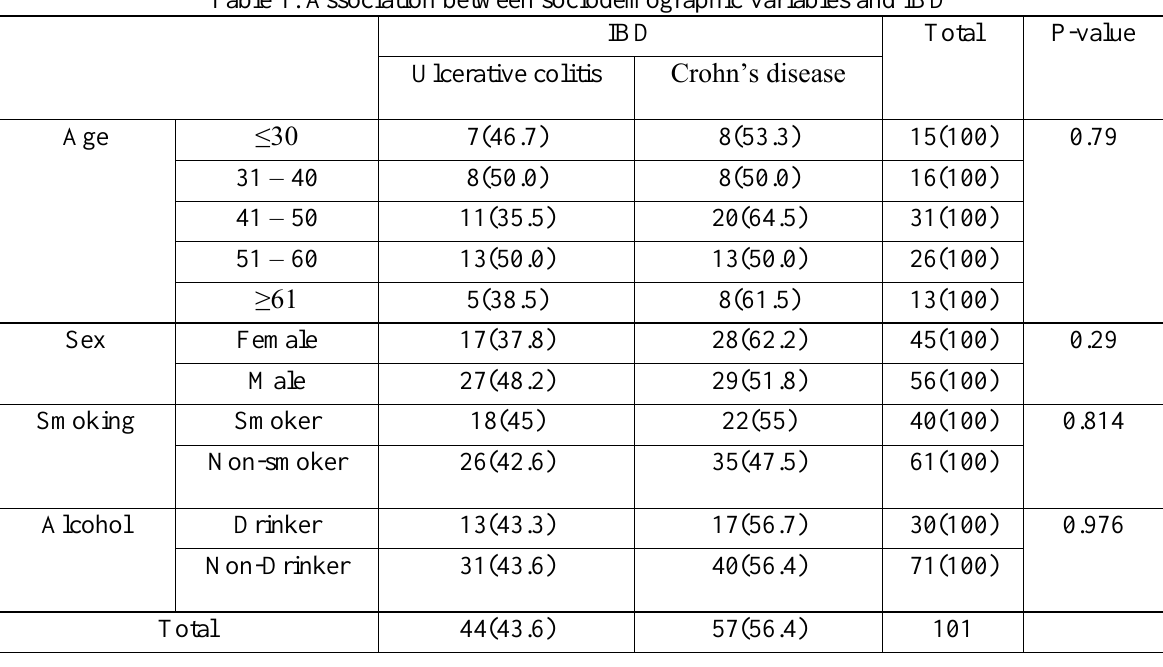
Table 1. Association between sociodemographic variables and